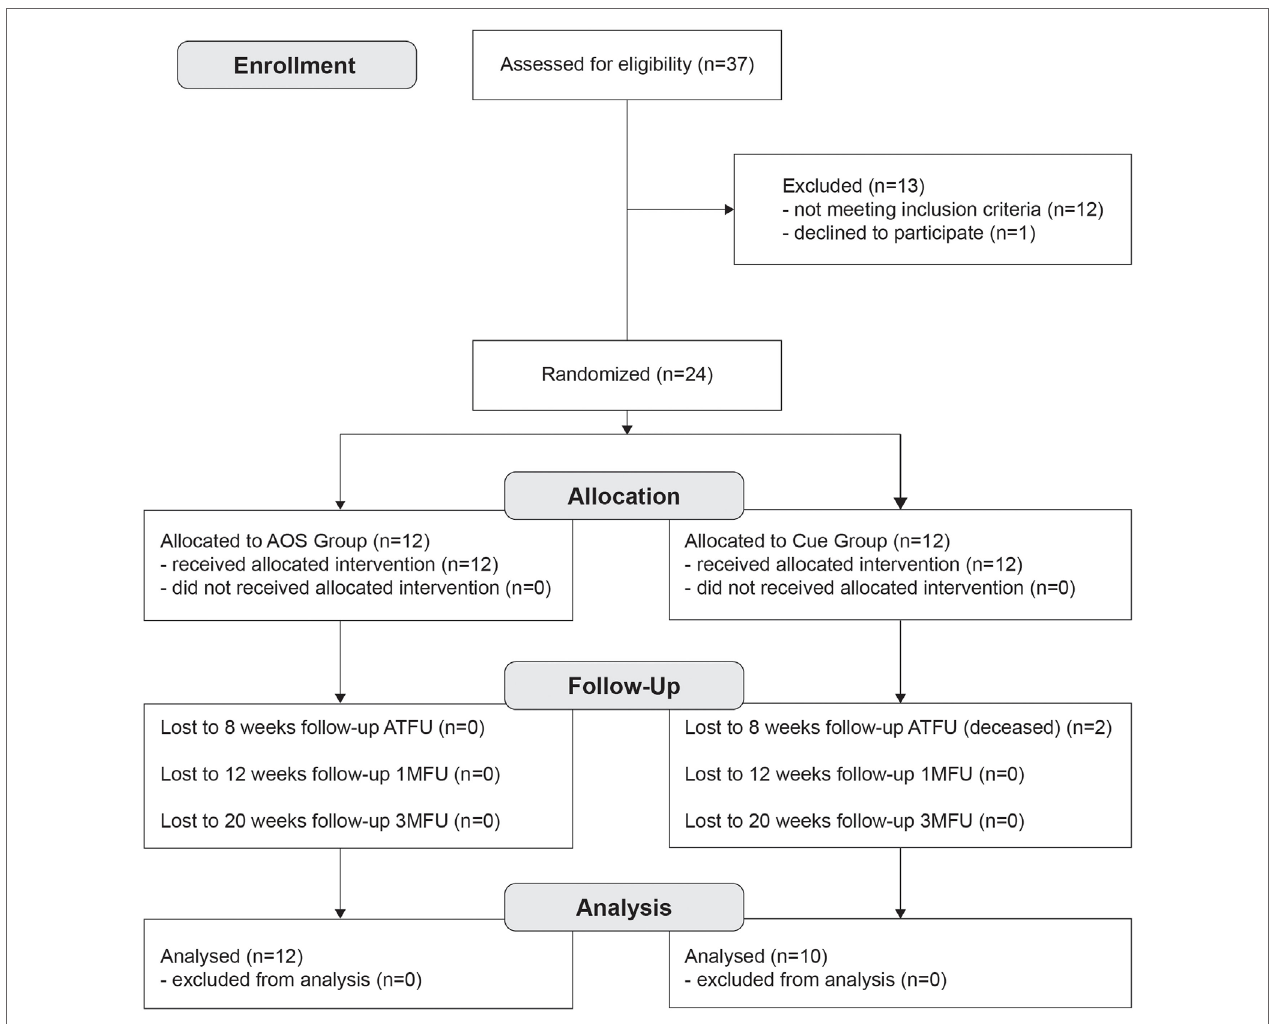
FiGUrE 1 | Flowchart showing the structure of the study, enrollment and evaluation procedure, and how the patients were divided into the groups, and